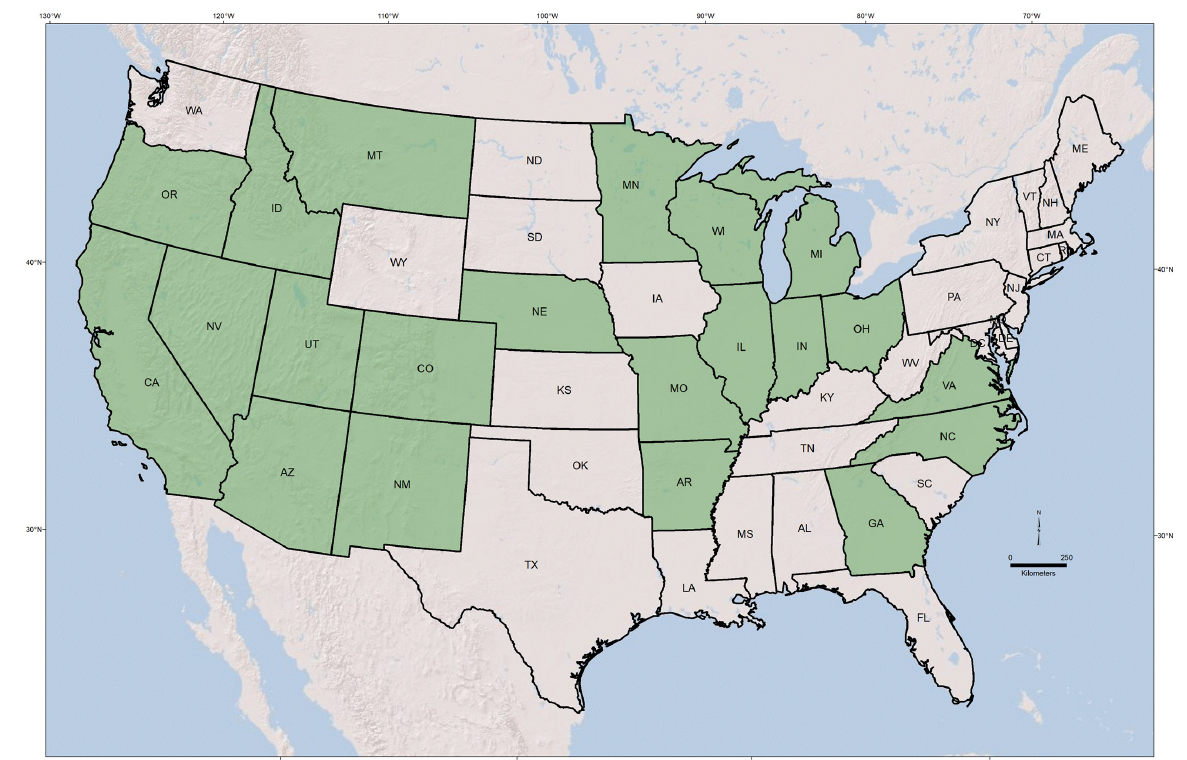
Figure 2. Locations of case study states (shaded). State abbreviations: AR (Arkansas), AZ (Arizona), CA (California), CO (Colorado), GA (Georgia), ID (Idaho), IL (Illinois), IN (Indiana), MI (Michigan), MN (Minnesota), MO (Missouri), MT (Montana), NE (Nebraska), NC (North Carolina), NM (New Mexico), NV (Nevada), OH (Ohio), OR (Oregon), UT (Utah), VA (Virginia), WI (Wisconsin).